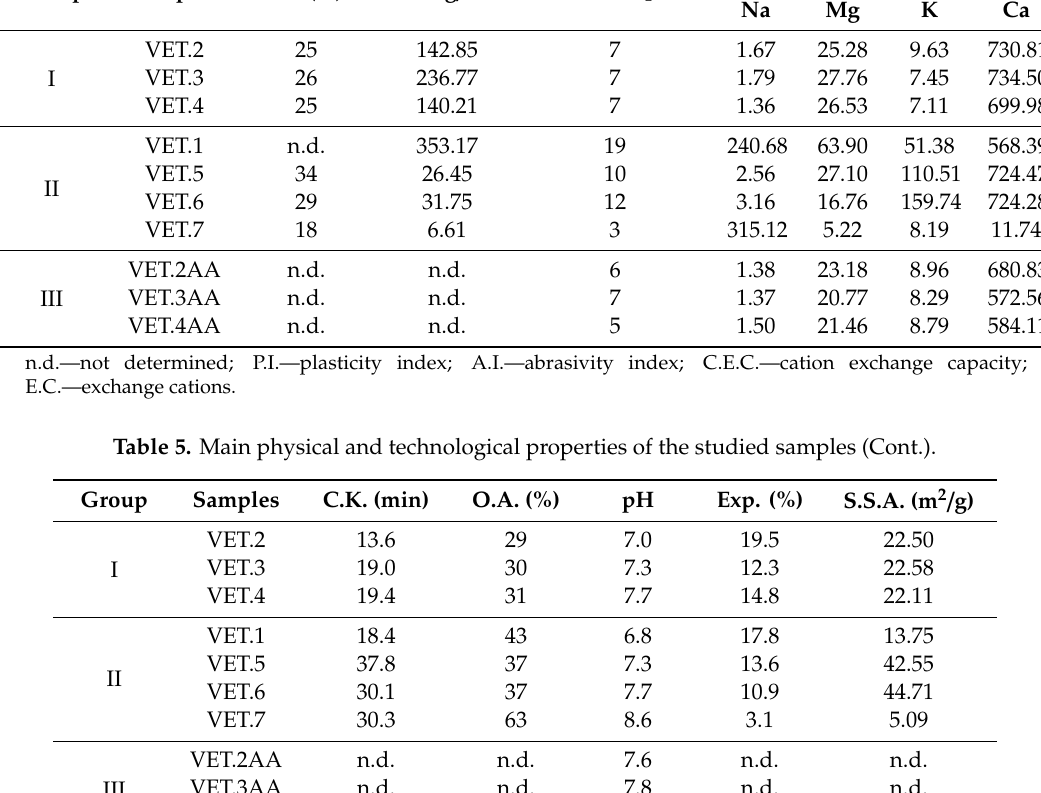
Table 4. Main physical and technological properties of the studied samples. Group